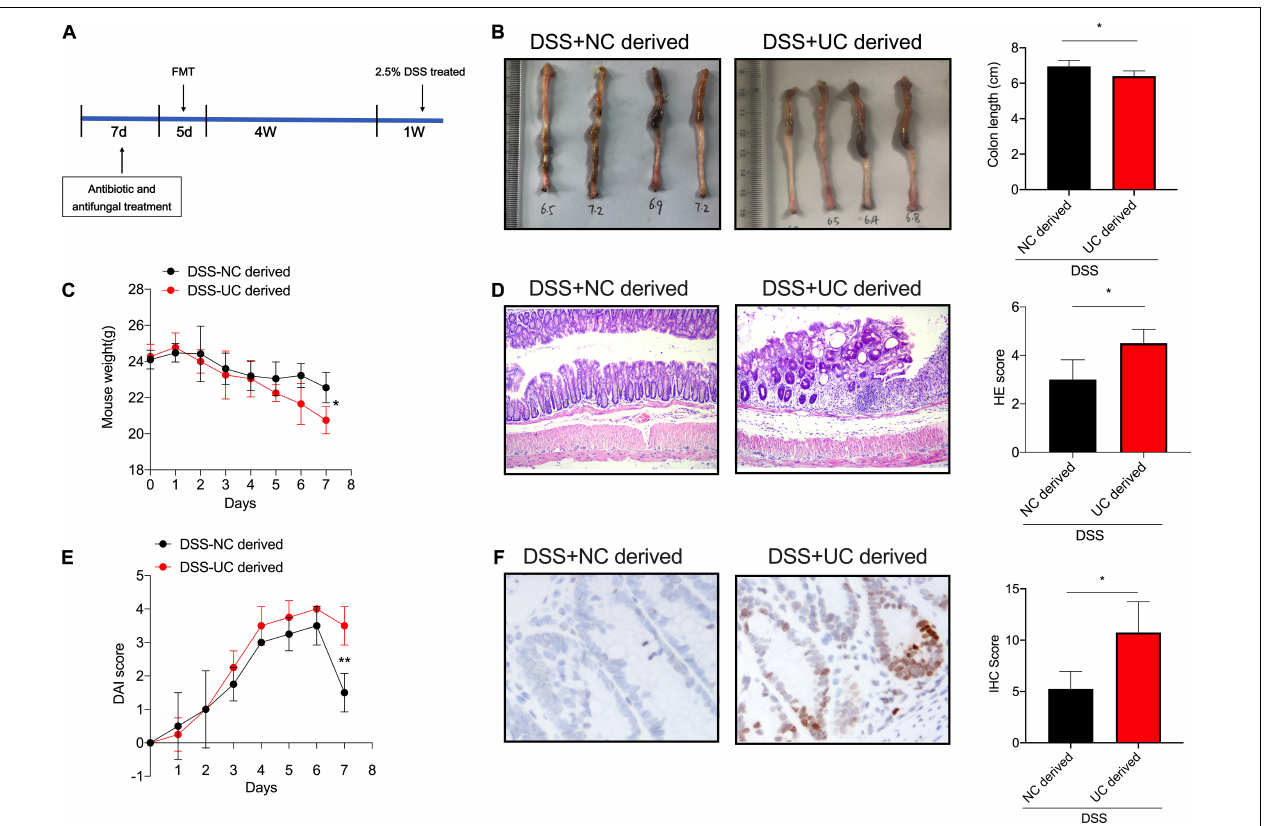
FIGURE 2 | DSS-induced colitis was evaluated among the mice administrated with feces derived from UC patients or healthy controls. (A) Schema of FMT model. The colon length (B) , body weight (C) , the H&E staining of sections (D) , and DAI score (E) , in colon tissues of mice between the two groups. (Magnification, × 20.) (F) The expression levels of γ H2Ax were determined by immunohistology in colon tissues of mice administered with feces derived from UC patients and healthy controls. (Magnification, × 20.) * p < 0.05, ** p <